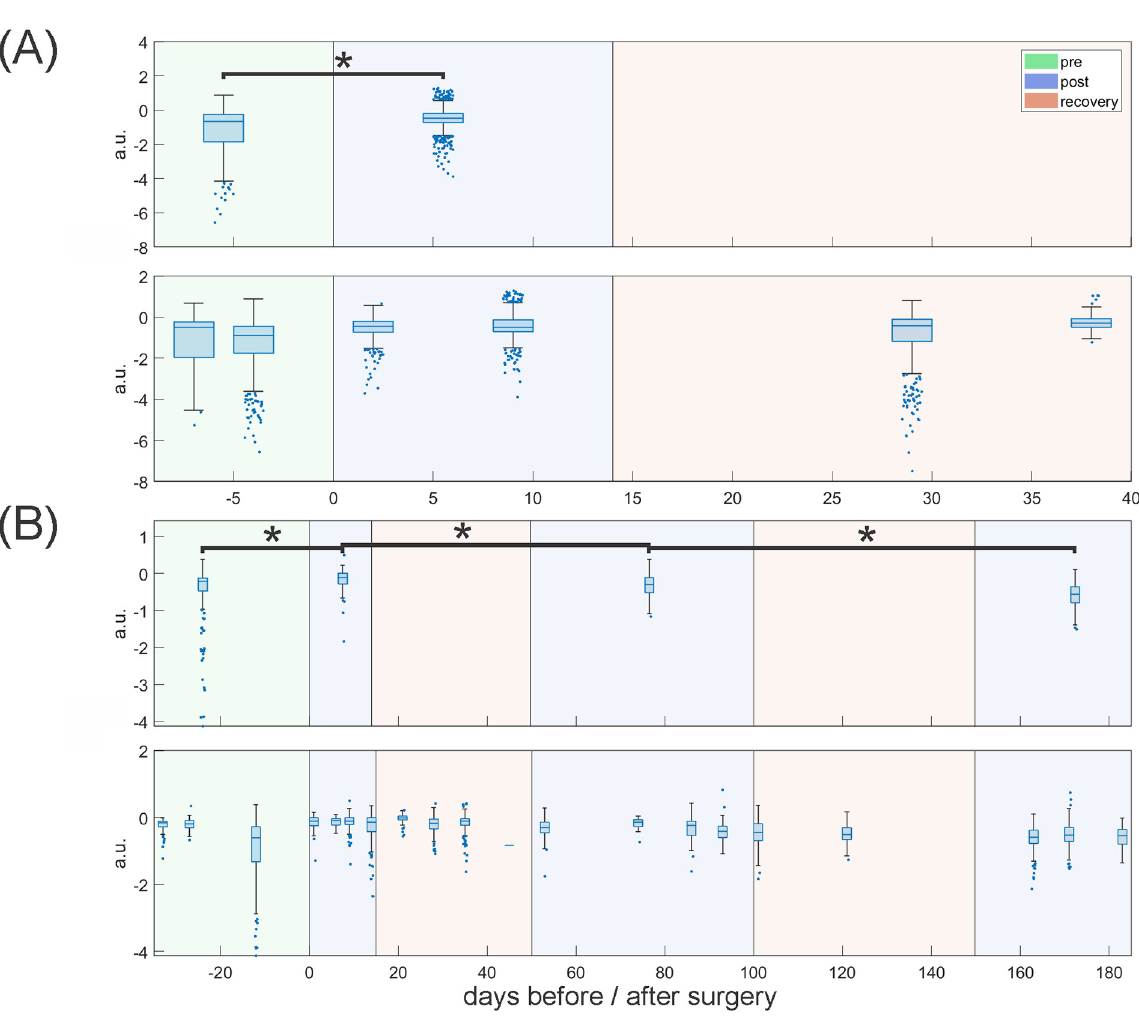
Fig 12. Change of LPC8 over time before and after COVR implant in (A) pig 3 and (B) pig 4. For statistical comparison in each section the top row shows boxplots of the random samples taken for analysis from the different time ranges (before surgery, up to 14 days after surgery, 50–100 days after surgery and more than 150 days after surgery). Bottom rows shows all recorded squeals on the dates indicated in the X-axis. The X- axis separates days before and after surgery at day 0. Data in the < 0 days and 0–14 days area was compared for pre-post-surgery comparisons. Pig 4 (B) also includes long-term comparisons. Asterisks indicate p <